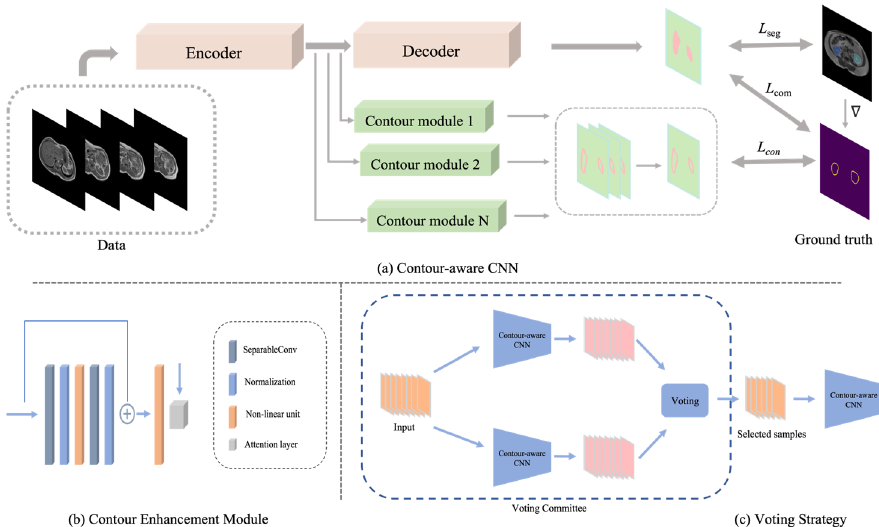
Figure 1. Illustration of two-stage segmentation framework. ( a ) Architecture of our contour-aware CNN in the first stage. ( b ) Detailed structure of the contour enhancement module. ( c ) Stage of voting strategy, where the voting committee filters the samples for the target network.